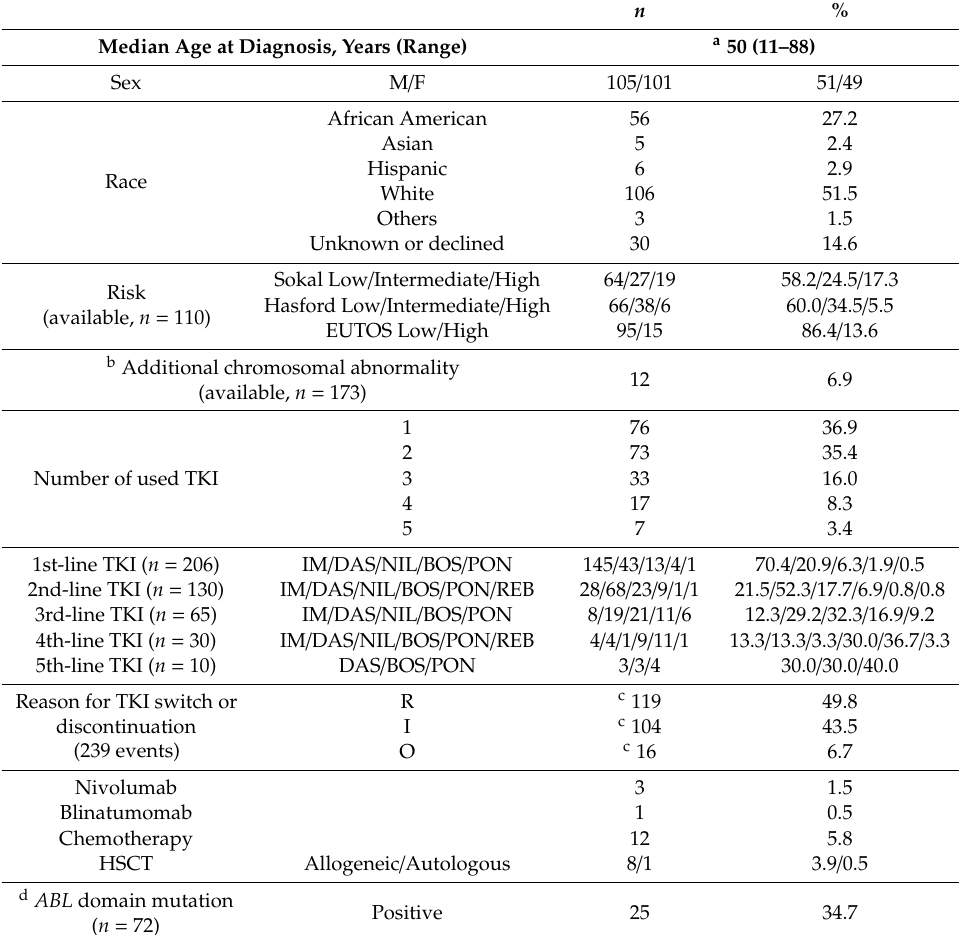
Table 1. Patients’ clinical